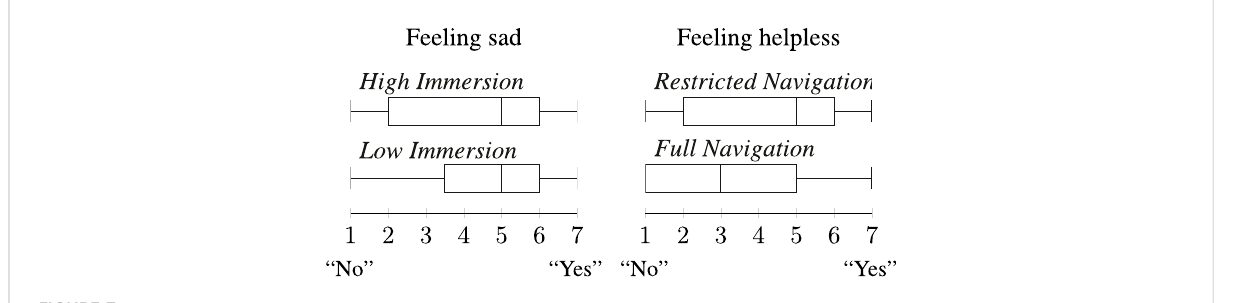
FIGURE 7 Distribution of participants ’ answers to “ feeling sad ” and “ feeling helpless ” on a 7-point Likert scale in the different conditions. Participants were speci fi cally asked to answer spontaneously. (The boxes show the medians as well as the 25% and 75%